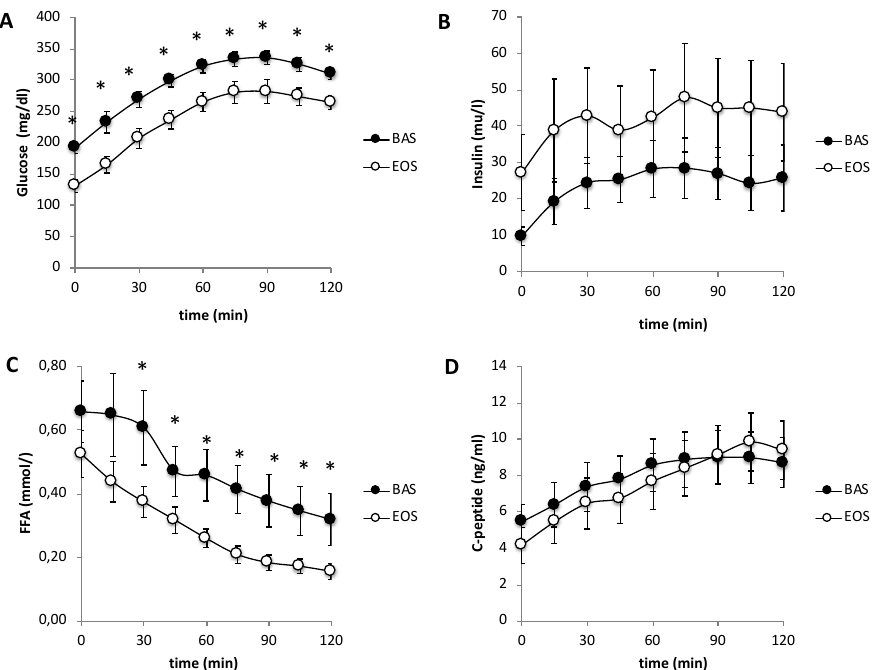
Figure 1. Plasma glucose ( A ), insulin ( B ), C-peptide ( C ), and FFA concentrations ( D ) during OGTT before (BAS) and after (EOS) 16 weeks of Inhaled insulin treatment. * p < 0.05. The mean plasma glucose concentration during the 24-h plasma glucose profile (212 ± 17 to 141 ± 8 mg / dl Figure 2A) was markedly decreased ( p < 0.0001) following Inhaled insulin treatment, with a greater decline in the postprandial compared to fasting glucose. Int. J. Mol. Sci. 2019 , 20 , x FOR PEER REVIEW